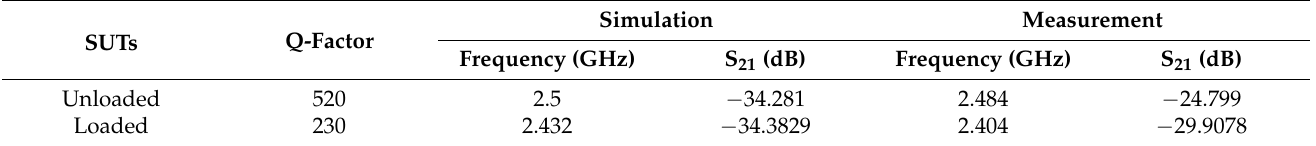
Table 4. Resonant frequency, Q—factor and S21 magnitude (dB) simulated and measured for triple- rings CSRR